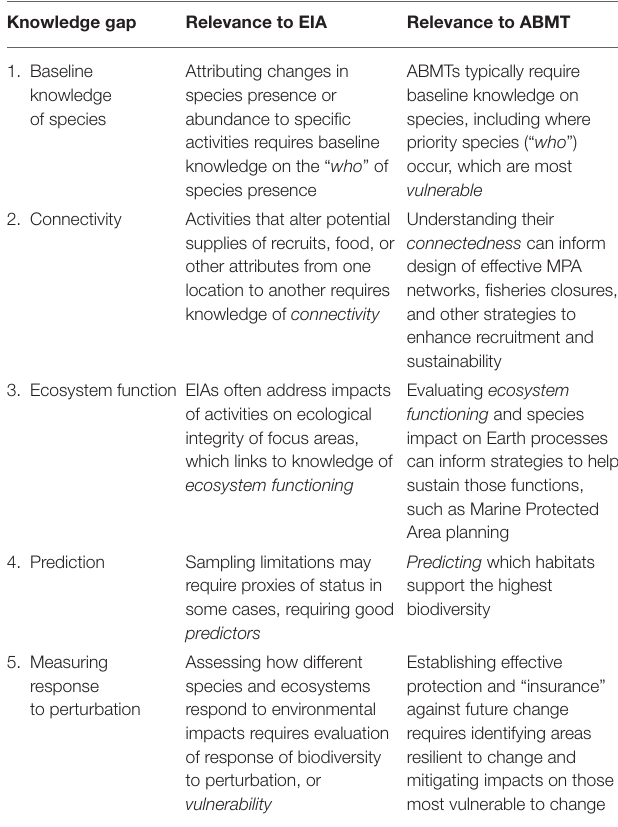
TABLE 4 | Scientific knowledge needs for the conservation and sustainable use of BBNJ, including relevance to both EIA and